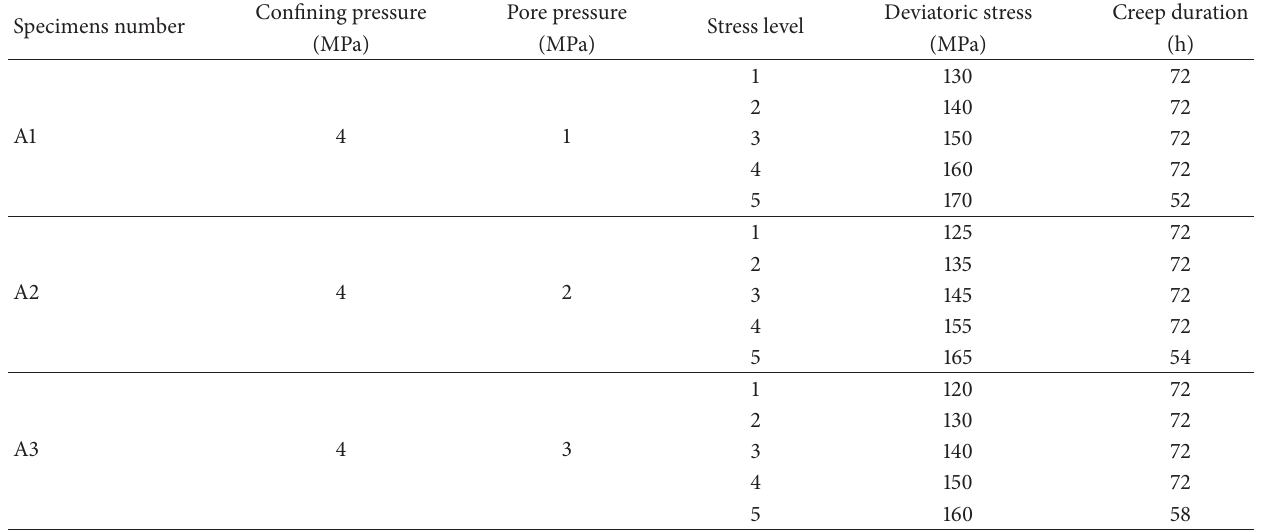
Table 2: Triaxial creep test conditions and preconfirmed deviatoric stress levels of the specimens. Specimens